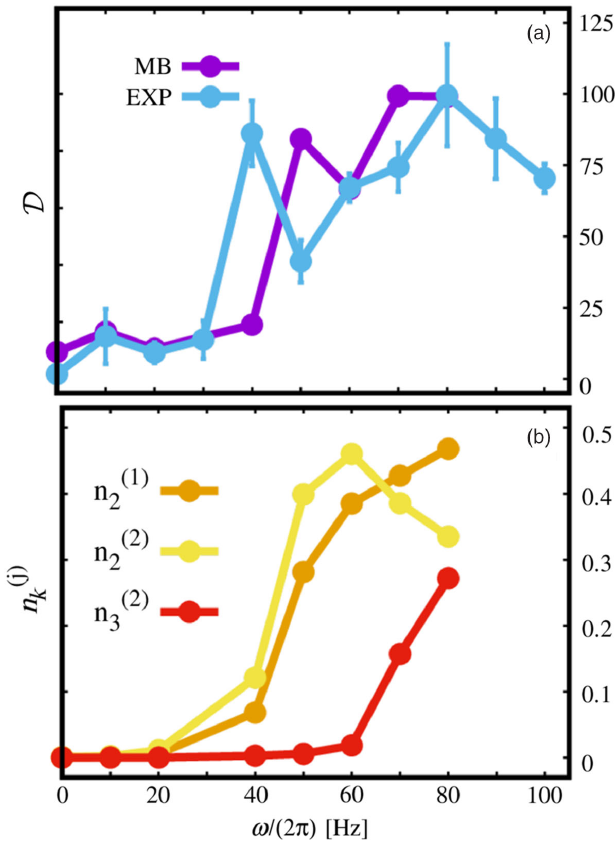
FIG. 9. Granulation vs ω . (a) Comparison of the deviations from a Thomas-Fermi distribution as quantified by the contrast parameter D ¼ D ð ω Þ [38] for single shots simulated with the MB theory with those taken in the experiment (EXP). The MB theory ≈ ð 2 π Þ 30 Hz, where deviations predicts the threshold value ω c become large and grains form. Each symbol and its error bar are the mean and standard error, respectively, of the mean of at least four experimental measurements of D , while 100 single shots at each ω are used for the MB simulations. (b) Eigenvalues of the first- and second-order RDM. The growth of all three is observed to occur for ω > ω , indicating the emergence of correlations and c ð 1 Þ ð 2 Þ ω ≈ ω fragmentation. The growth of both n , 2 and n 2 occur as c ð 2 Þ with the drop in n 2 near 60 Hz corresponding to the subsequent ð 2 Þ growth in n 3